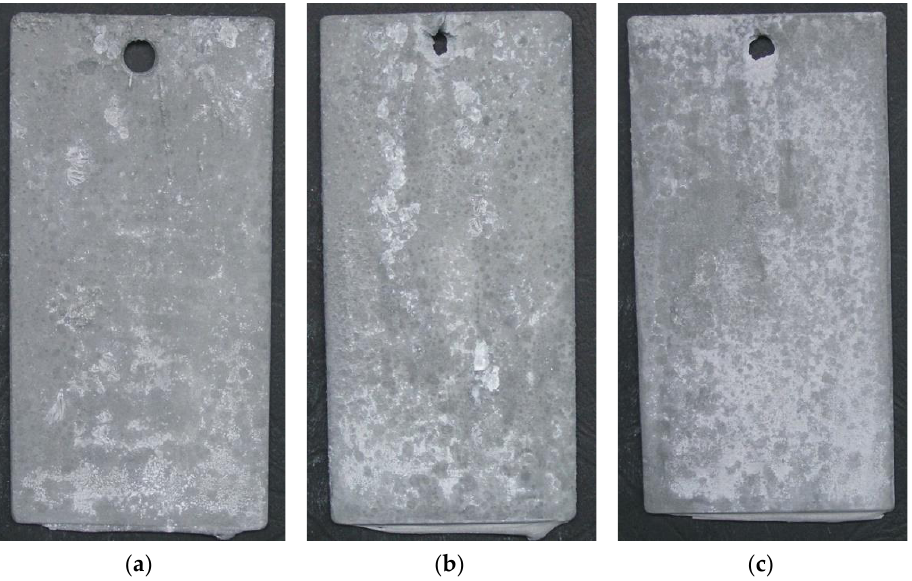
Figure 11. The appearance of the surface of research coatings obtained in the: ( a ) ZnAl23Si0.4, ( b ) ZnAl23AlMg3Si0.4 and ( c ) ZnAl23AlMg6Si0.4 bath after 30 cycles of exposure in sulfur dioxide test in a humid atmosphere.